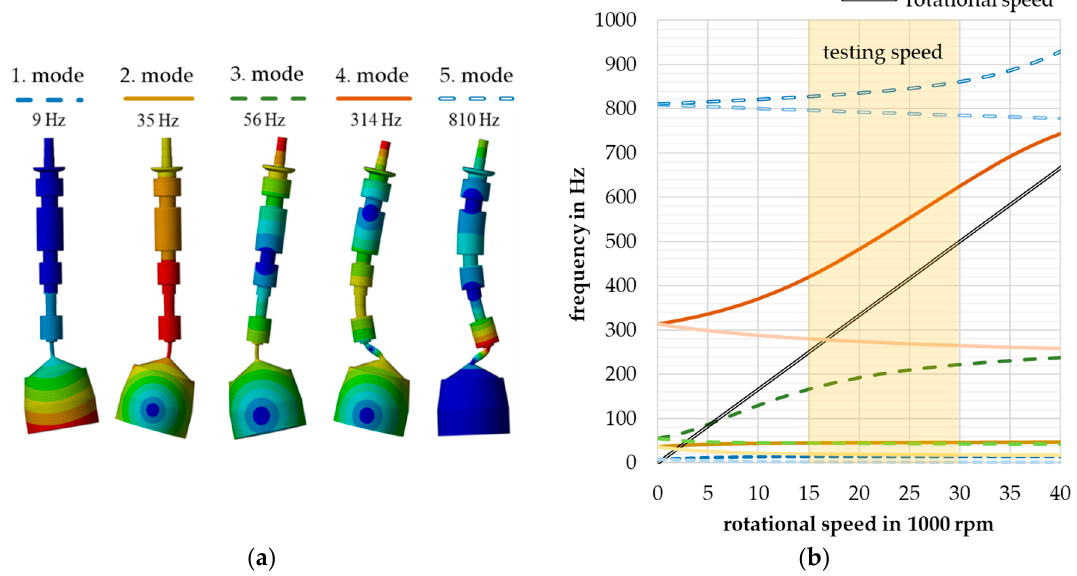
Figure 13. ( a ) Calculated bending eigenmodes below 1 kHz of the rotor with sample; ( b ) Calculated Campbell diagram of the rotor with the specimen. Each eigenmode shown in ( a ) splits in a forward and a backward mode.